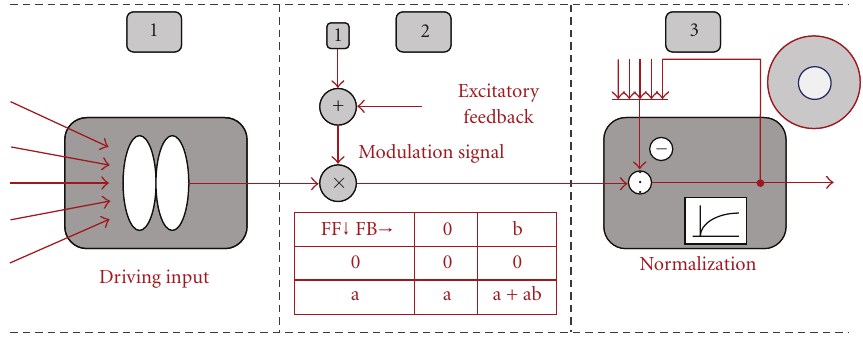
Figure 2: Three-stage cascade of dynamical processing stages used to determine the activation level of cells in one model area. Stage 1 (left) pools the bottom-up input signal by a filter mechanism that implements the respective cells’ receptive field properties. The resulting activity is fed forward through the next stages of the cascade. Stage 2 (middle) realizes a multiplicative feedback interaction from higher model areas to modulate the initial activation from the filtering stage. This mechanism implements a linking strategy in which the feeding input is required to drive the response, while feedback signals can only modulate the driving input. Feedback cannot by itself generate any new activation. On the other hand, the lack of feedback does not lead to the extinction of activities along the feedforward path such that these activities are left unchanged. In Stage 3 (right) the top-down modulated activity undergoes a stage of shunting on-center/o ff surround competition over a neighborhood in the spatial and feature